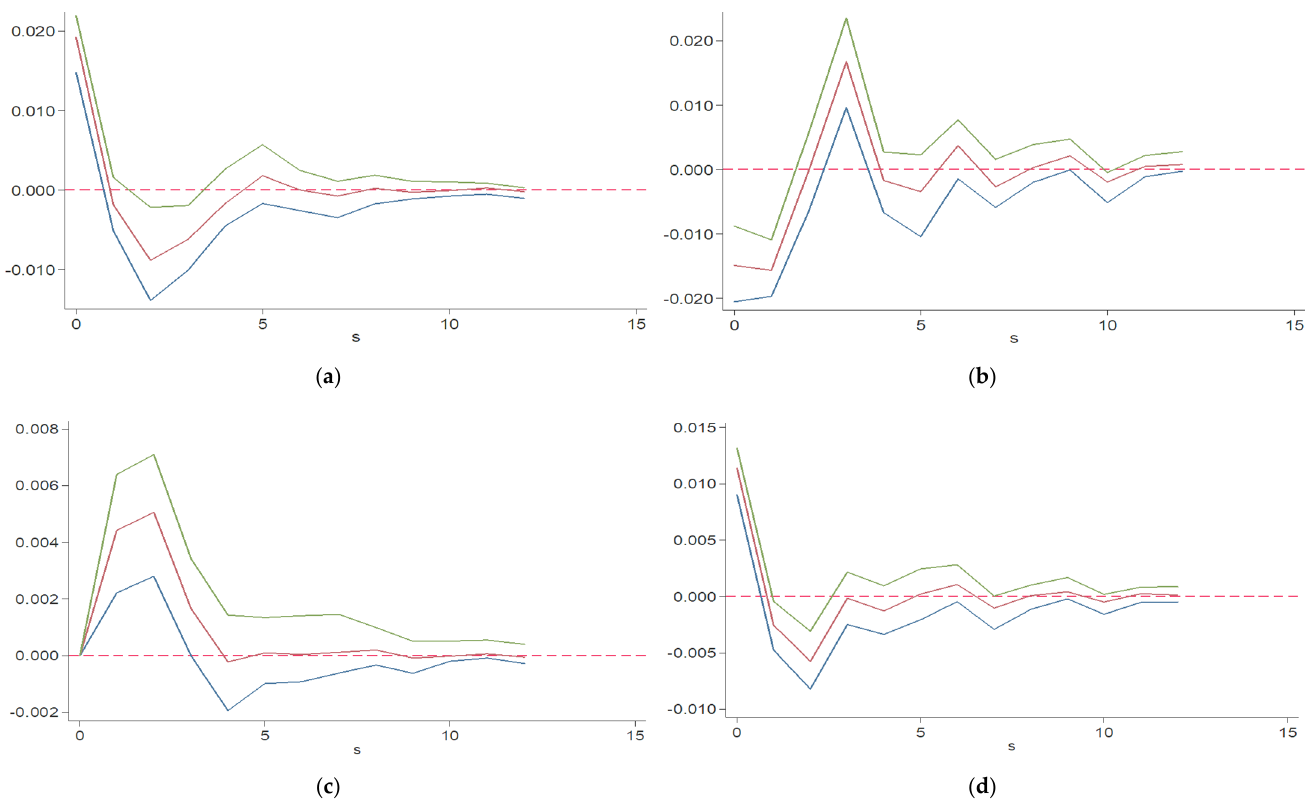
Figure 2. Corresponding results of pulses: ( a ) GE response to GE shock; ( b ) GE response to CO shock; ( c ) CO response to GE shock; ( d ) CO response to CO shock.